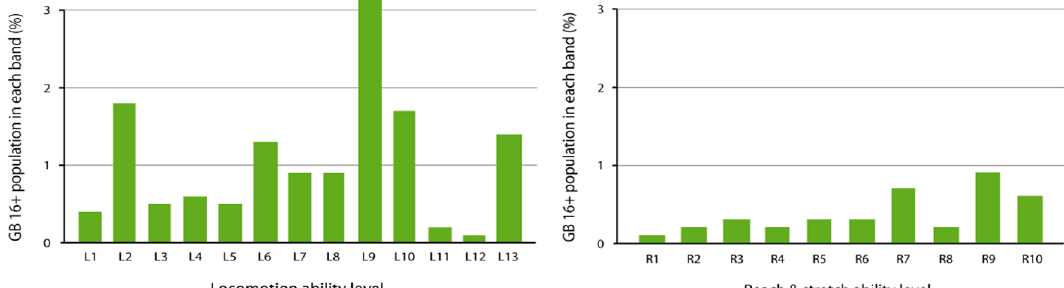
Figure 14. Disability prevalence data from the DFS for locomotion (L1 to L13 are the questions listed in table 2) and reach & stretch (R1 to R10 are the questions listed in table 3). From the Inclusive design toolkit: user capabilities. Source: Clarkson, Coleman, Hosking, and Waller